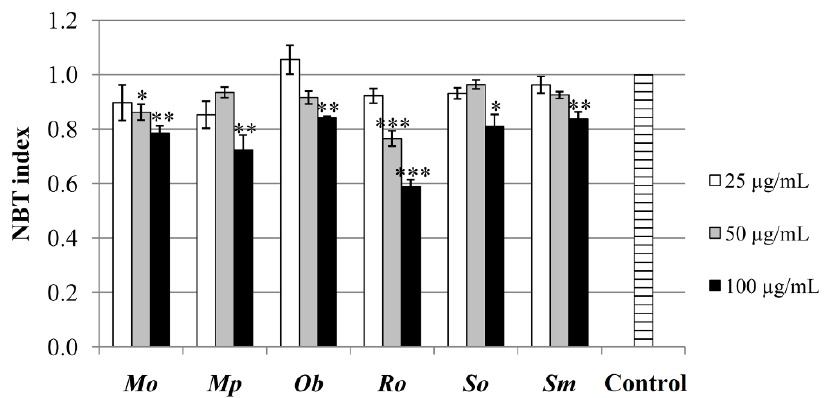
Figure 5. NBT assay performed in the extracts’ concentrations of 25, 50, and 100 µ g/mL and expressed as NBT index–ratio between absorbance of treated cells and untreated control, calculated on 100% viable cells. * p < 0.05; ** p < 0.01; *** p < 0.001—statistically significant increase in ROS production by HCT-116 cells in comparison with the untreated control.